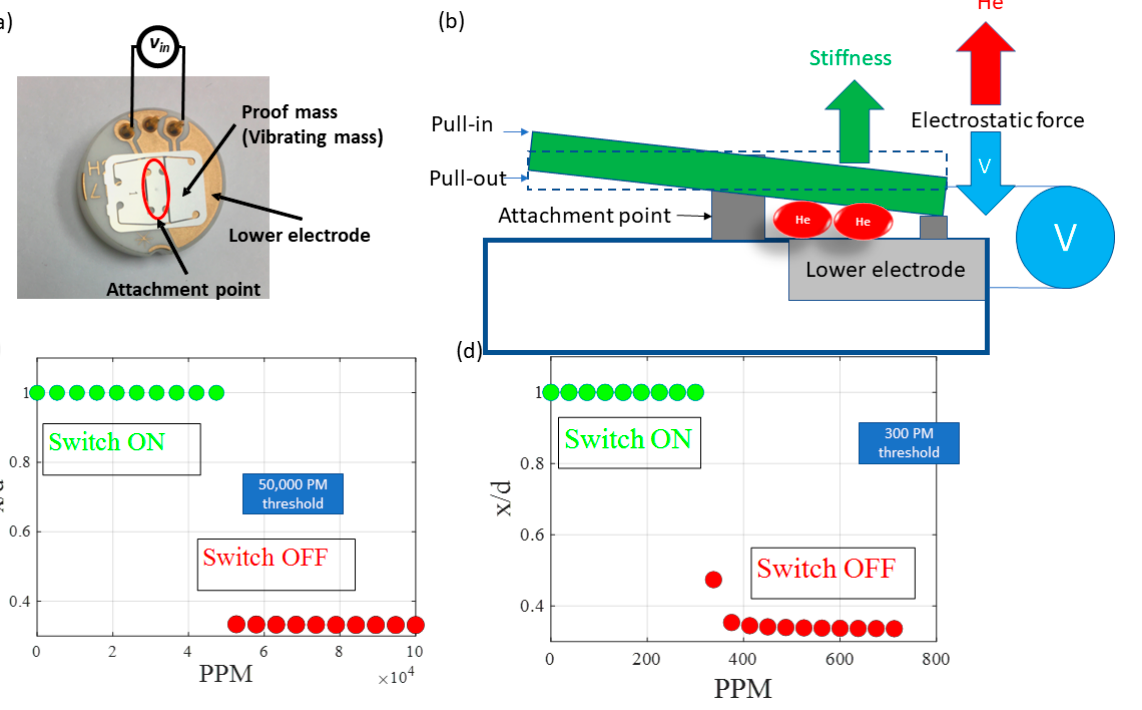
Figure 2. ( a ) An image of the MEMS sensor and ( b ) a schematic. The sensor response at different helium concentration levels ( c ) using the typical DC bias operation and ( d ) adding a small AC voltage signal that activates the electrical resonance circuit formed by the MEMS capacitance.